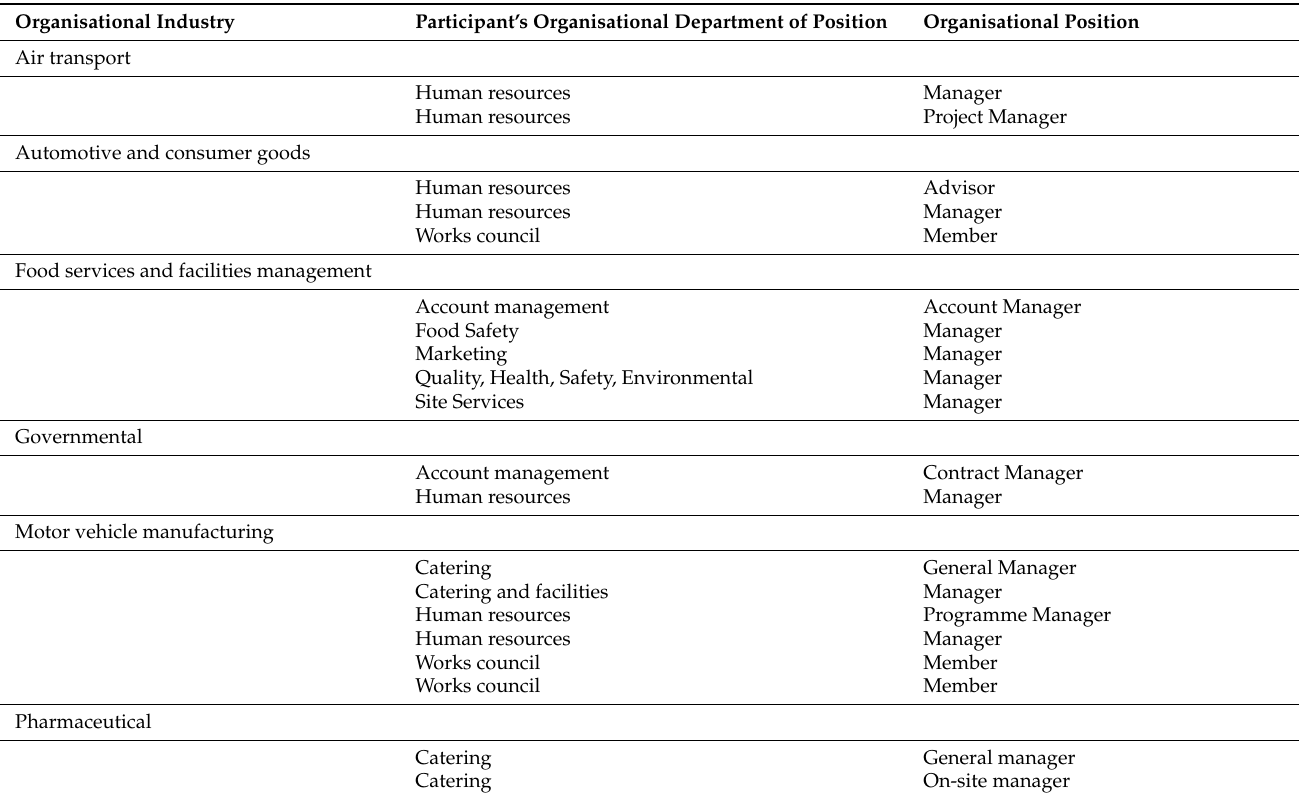
Table 1. Organisational characteristics related to the study participants ( n =